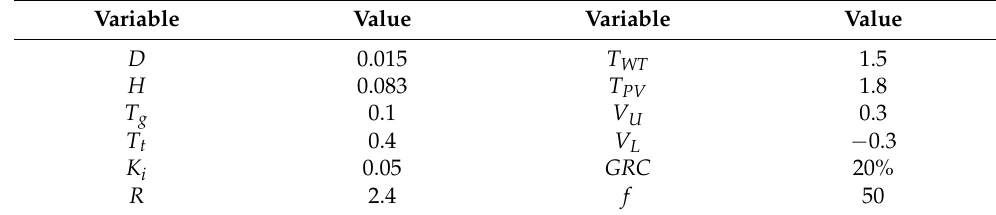
Figure 2. A dynamic model of the studied µG with the proposed ULM incorporated into the secondary controller. Table 1. Dynamic variables of the studied µG.